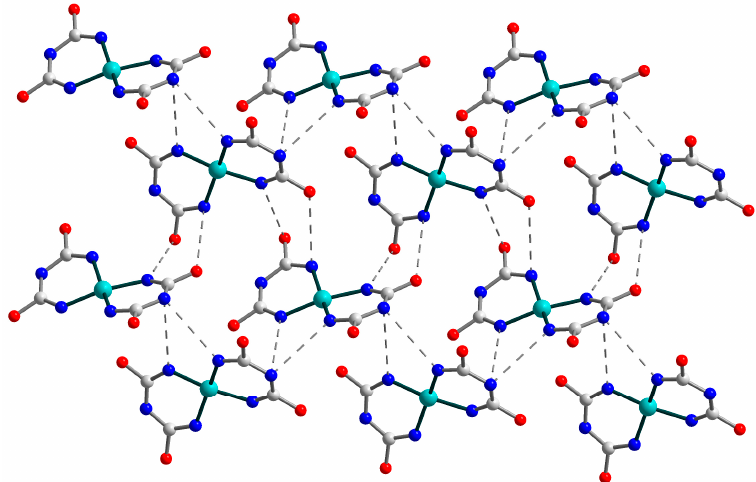
Figure 2. The fragment of the supramolecular layer in 3 viewed down the a axis. H and C atoms from the alkyl chains are omitted for clarity. Colour scheme: Cu, cyan; O, red; N, blue; C, grey. Table 1. Selected geometrical parameters (distances/Å and angles/°) for 3 .